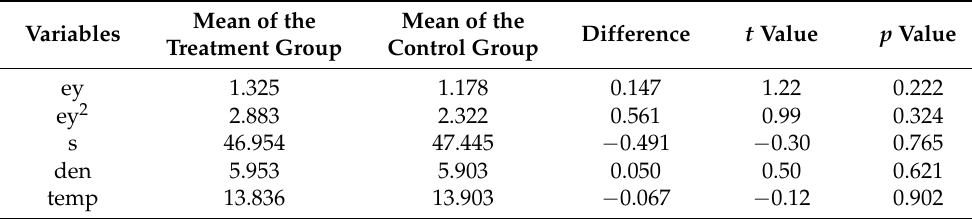
Table 4. Applicability test of the PSM-DID method (common support hypothesis).